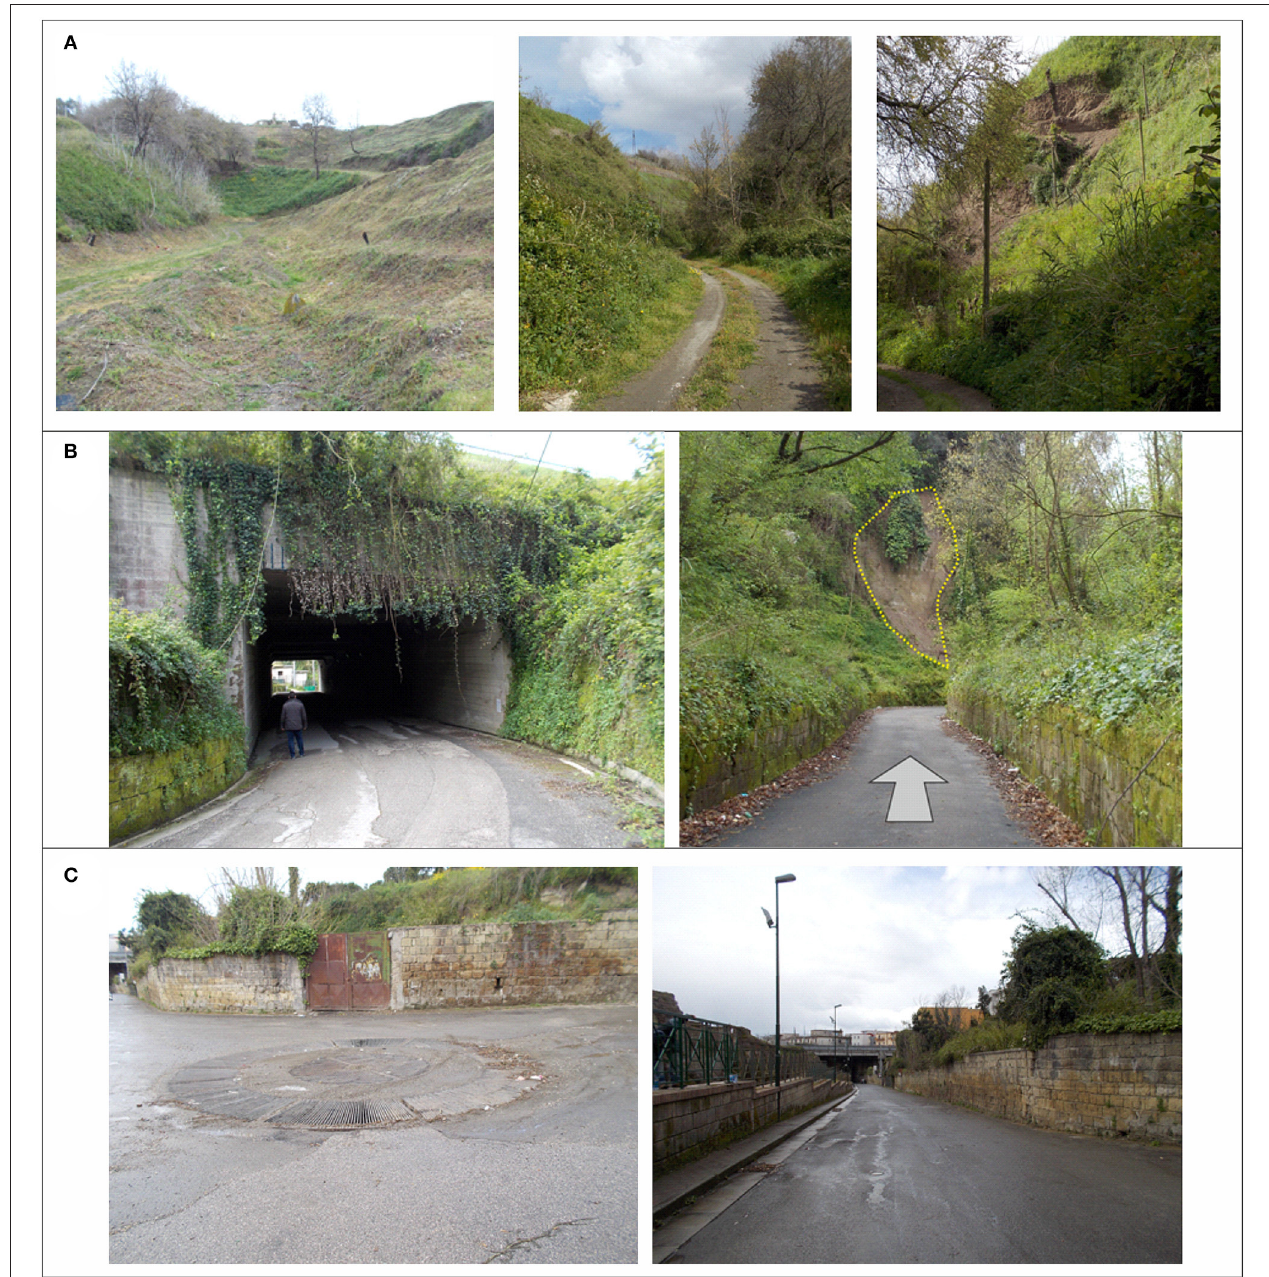
FIGURE 7 | Photographs of the different sectors of the studied watershed: (A) hilly sector with hollows and partly-natural channels, and soil slips along the slopes; (B) intermediate sector with a tunnel passing under the highway, and a drainage channel transformed in a road for connecting the urban center; the dashed line highlights the scar of a shallow landslide triggered by intense rainfalls; (C) lower and fully urbanized